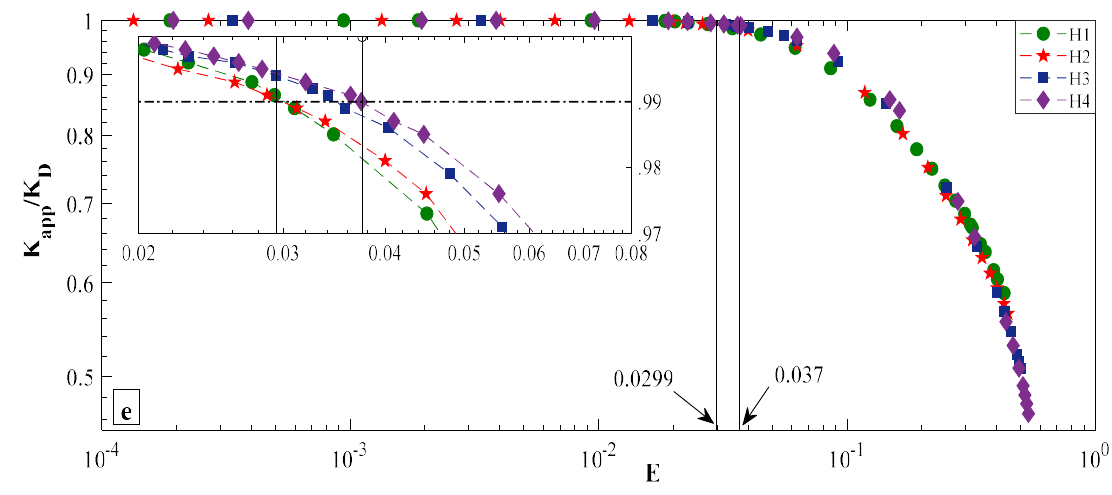
Figure 2. Dependency of K app about the series numbers, please follow Section